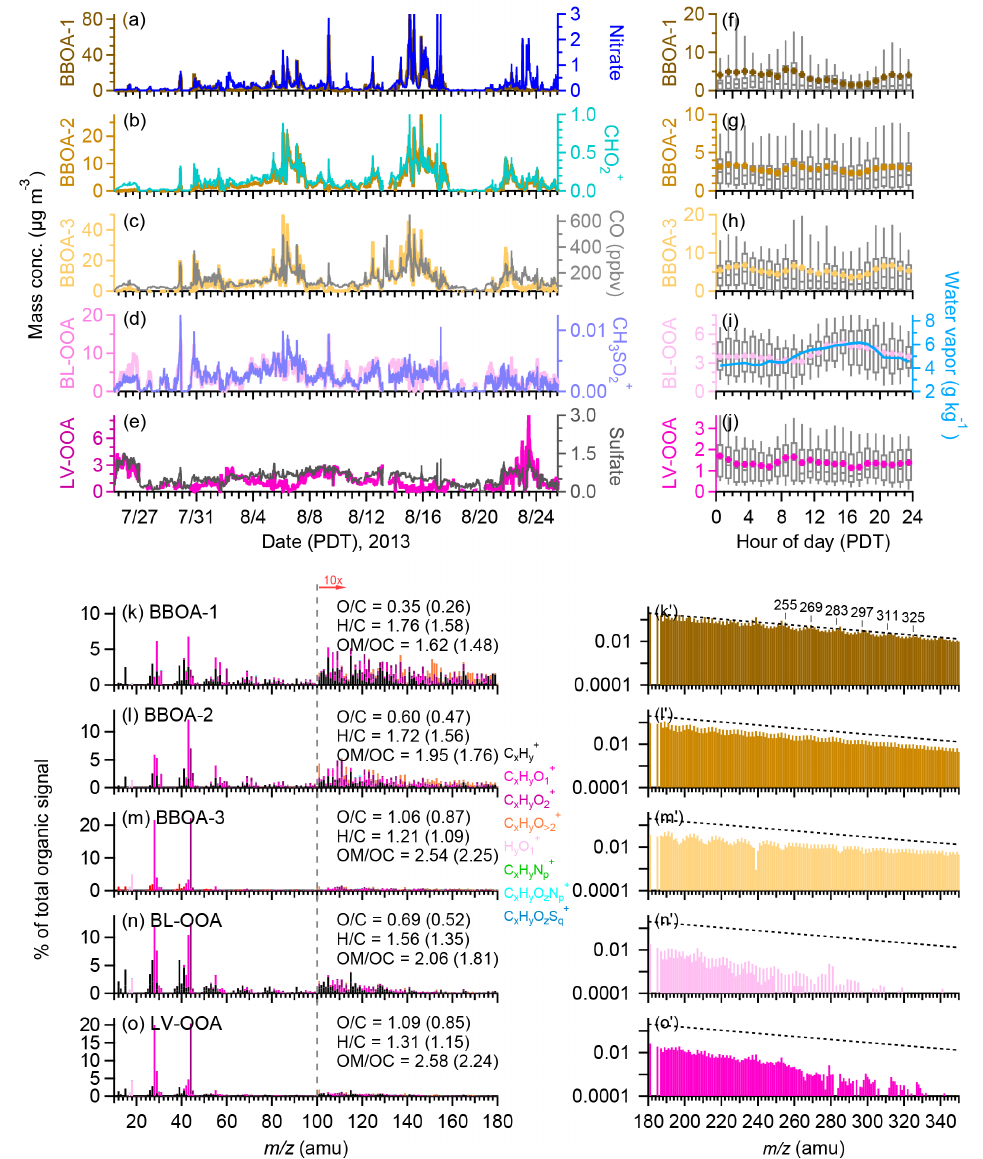
Figure 5. (a–e) Time series of OA factors and corresponding tracer compounds. Organic ions are in organic equivalent mass; (f–g) diurnal variations of OA factors (the whiskers above and below the boxes indicate the 90th and 10th percentiles, the upper and lower boundaries respectively indicate the 75th and 25th percentiles, the lines in the boxes indicate the median values, and the cross symbols indicate the mean values) with the diurnal cycle of mean water vapor in panel (i) ; (k–o) HRMS of OA factors colored by eight ion families at m/z <180, and (k (cid:48) –o (cid:48) ) UMR MS at m/z >180 for each OA factor. The elemental ratios of each OA factor are shown in the legends of panels (k–o) , with those obtained using the AA method in